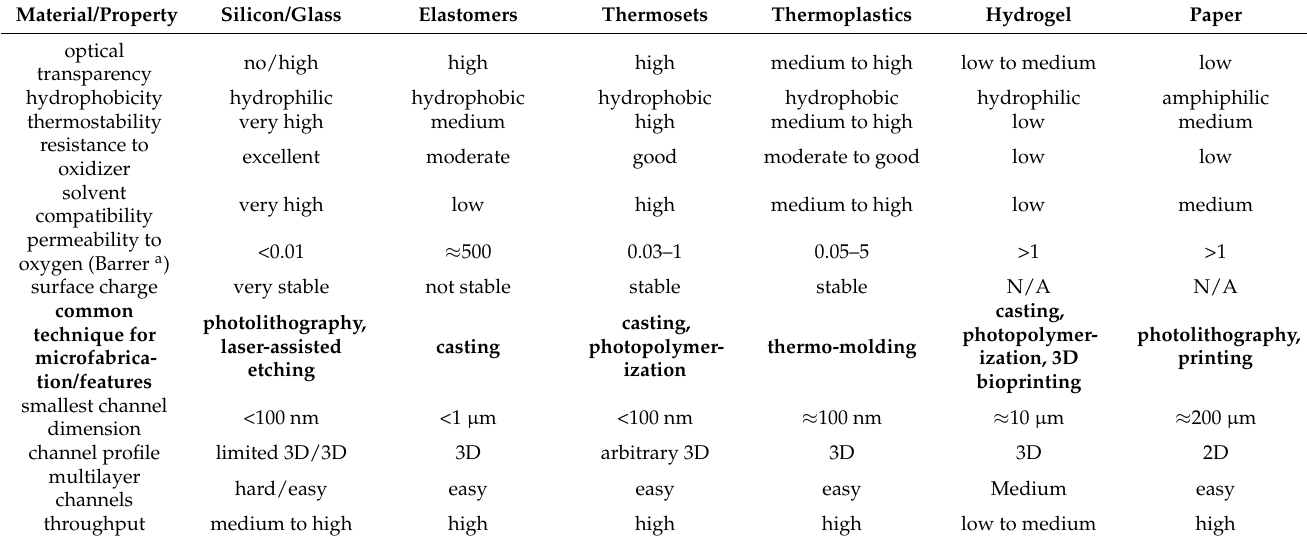
Table 1. Properties of materials and processing technologies typically used for the fabrication of microfluidic devices (adapted from